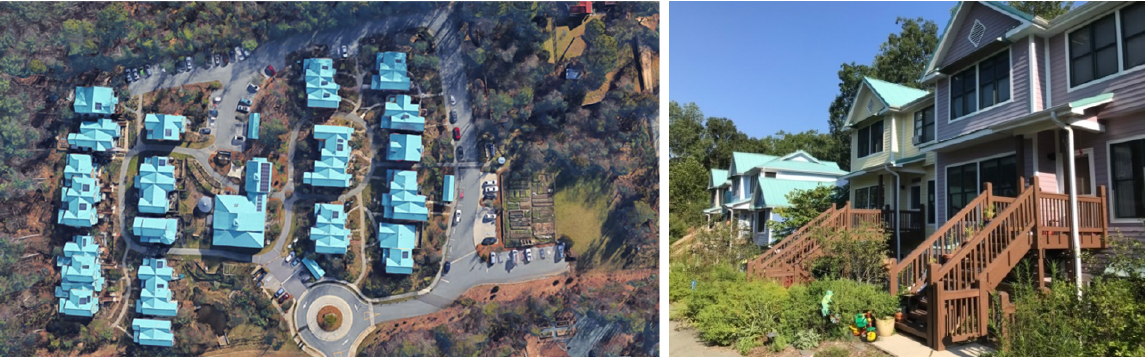
Figure 4. Pacifica Cohousing from the air, left and on the ground.